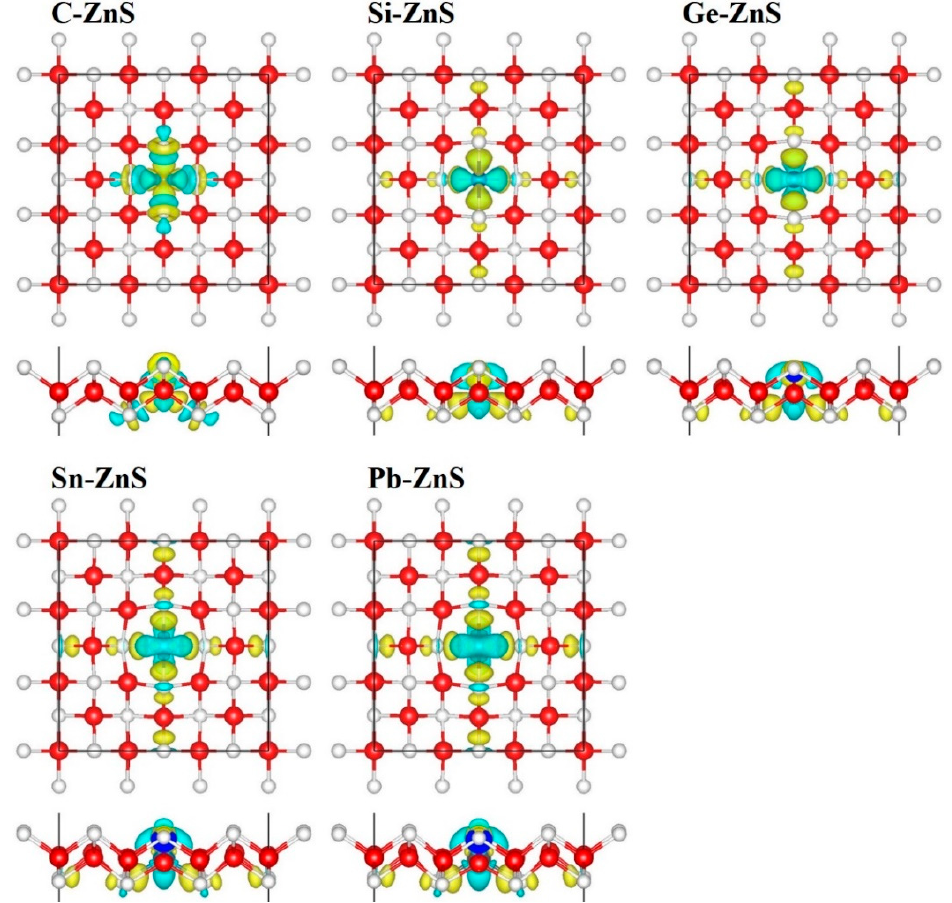
Figure 5. The difference in charge densities of monolayer C − ZnS, Si − ZnS, Ge − ZnS, Sn − ZnS, and Pb − ZnS, respectively, with an iso-surface of 0.002 Å − 2 . The electron localization functions (ELF) of the ZnS monolayer and the associated doping models are shown in Figure 6. Usually, ELF = 0.5 corresponds to the metallic bond where electrons are totally delocalized, while ELF = 1 corresponds to the covalent bond where the electron is perfectly localized. For the ZnS monolayer, the values of ELF be- tween the Zn and S atoms are relatively small, revealing that the Zn and S atoms tend to form ionic bonds. For C − ZnS, the values of ELF between C and S atoms are notably en- hanced, and the ELF around the C atom is distributed uniformly, suggesting that C and S atoms tend to form σ bonds. As for Si − , Ge − , Sn − , and Pb − ZnS, the charge around the Si, Ge, Sn, and Pb atoms shows a prominent orientation deviating from the bonding direc- tion, illustrating that the π bonds are formed in these cases. This diversity between doping elements is probably due to the difference in chemical bonds.